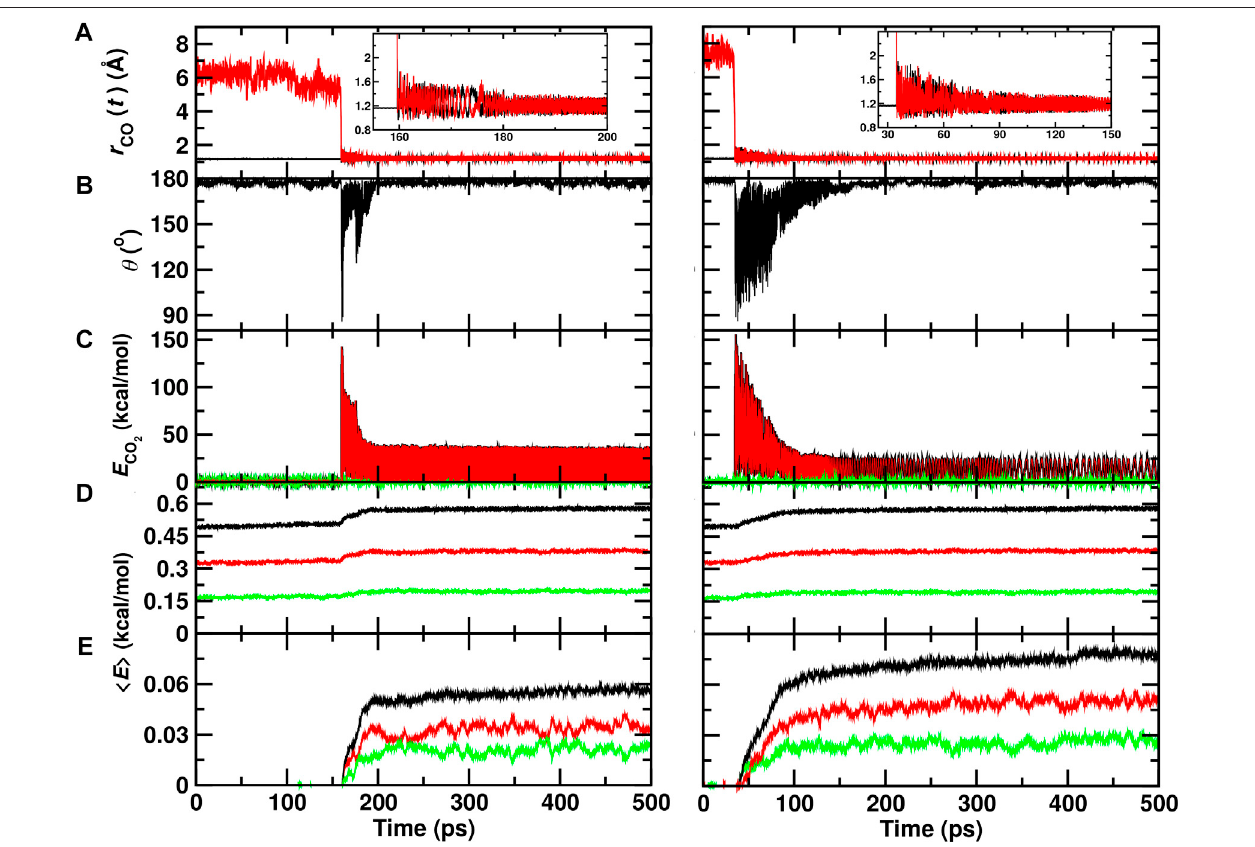
FIGURE2| RecombinationofO( 1 D)+CO( 1 Σ + )toformgroundstateCO 2 ( 1 Σ g ) intheASWcavity(left column)andontopoftheASWsurface(rightcolumn).Initially, R (cid:2) 6.0 Åand θ (cid:2) 180 ° . (A) : O B – C CO separation (red) and CO A separation (black); (B) : theO-C-O angle θ ; (C – E) : the average total(black), internal (red), and translational (green) energies for the CO 2 molecule (C) , the average per water molecule (D) , and the magnitude of the average per water molecule relative to the energy before recombination (E)